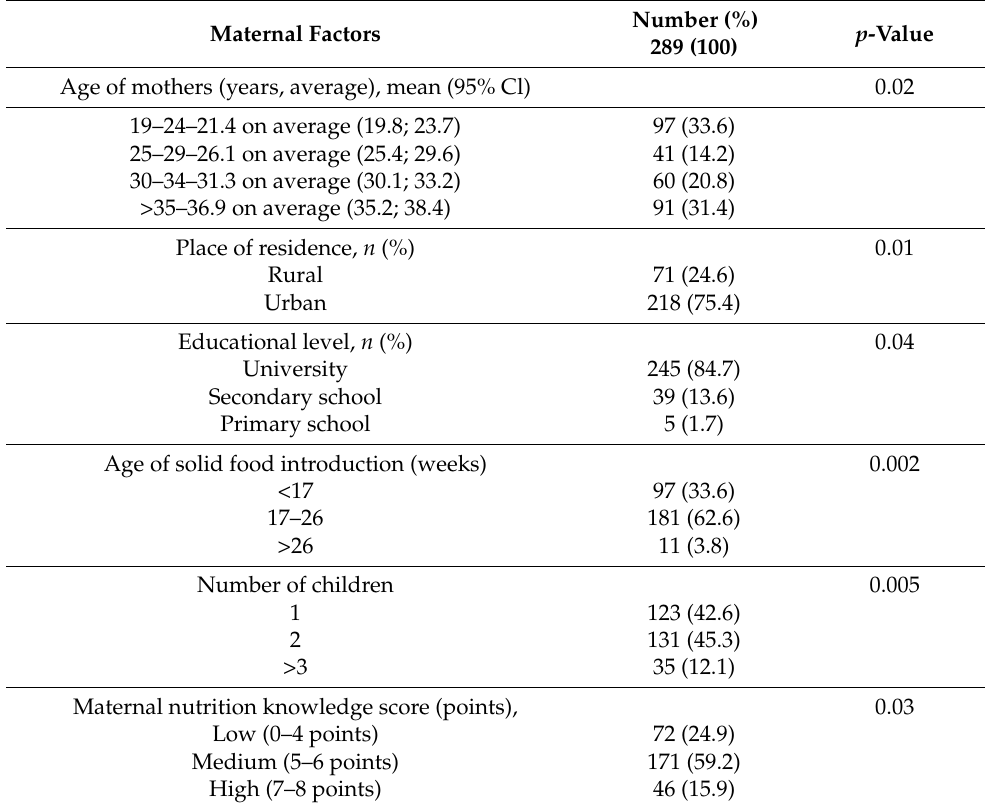
Table 1. Maternal